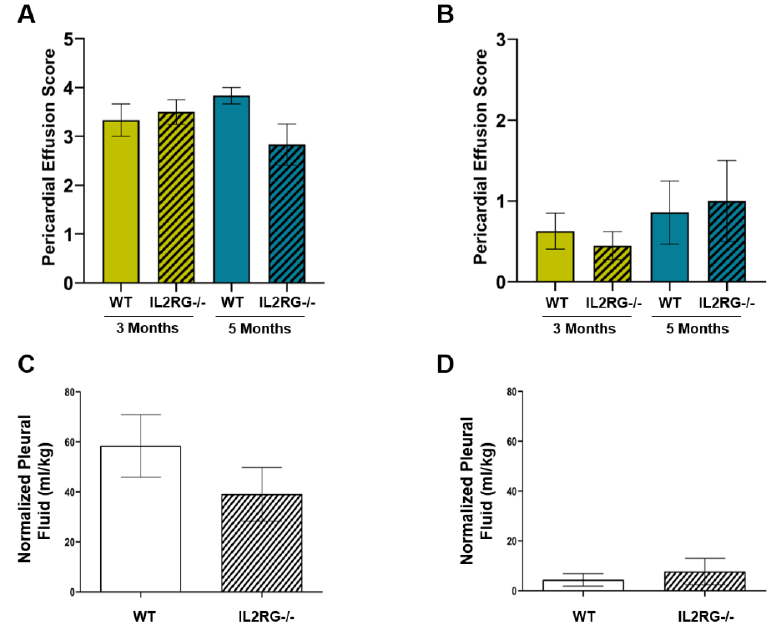
Figure 3. SS interleukin-2 receptor gamma chain knockout (IL2RG −/− ) rats exhibit no significant differences in pleural or pericardial effusions after 24 Gy localized heart RT treatment, compared with the SS WT immune-competent rats. Adult female rats were treated with 24 Gy of image-guided cardiac radiation therapy (RT). Pericardial effusions were given a score of 0–4 during echocardiogram at three months and five months post-RT for ( A ) females and ( B ) males, with the group average scores displayed. Pleural effusions were collected and quantified at harvest, and normalized to body weight with the ( C ) females having larger amounts of effusion compared to ( D ) males, but no statistical difference was seen between the SS IL2RG −/− and immune-competent SS WT rats. No control rats had pericardial or pleural effusions (not shown). Values are means ± SEM; n = 9–15 rats/group. No p - values comparing the WT versus IL2RG −/− rats were <0.05.